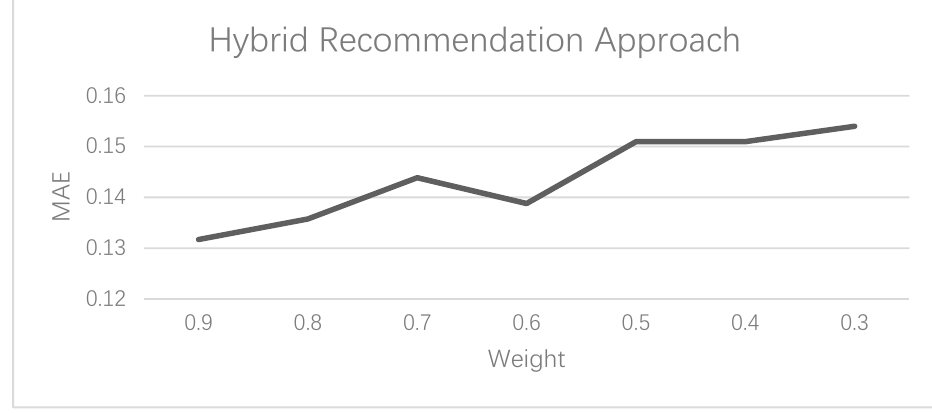
Figure 7. MAE values of the hybrid recommendation approach under different weights.